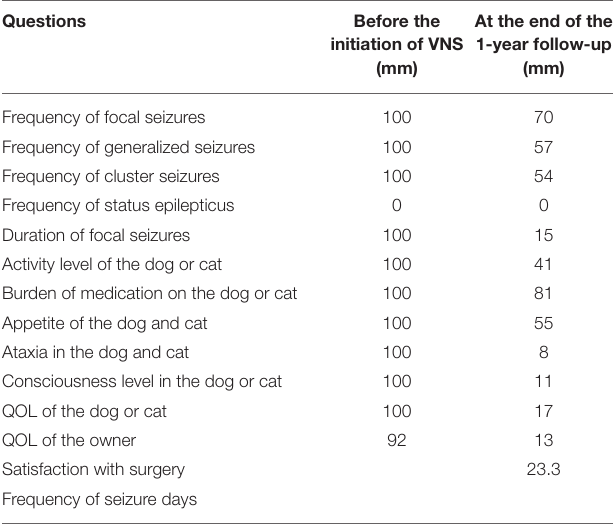
TABLE 1 | VAS scale before VNS initiation and at the end of the 1-year follow-up of VNS therapy.